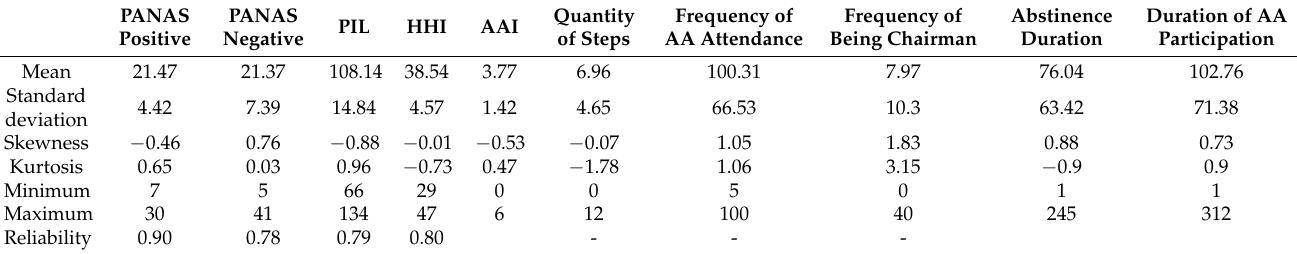
Table 2. Descriptive statistics ( n =